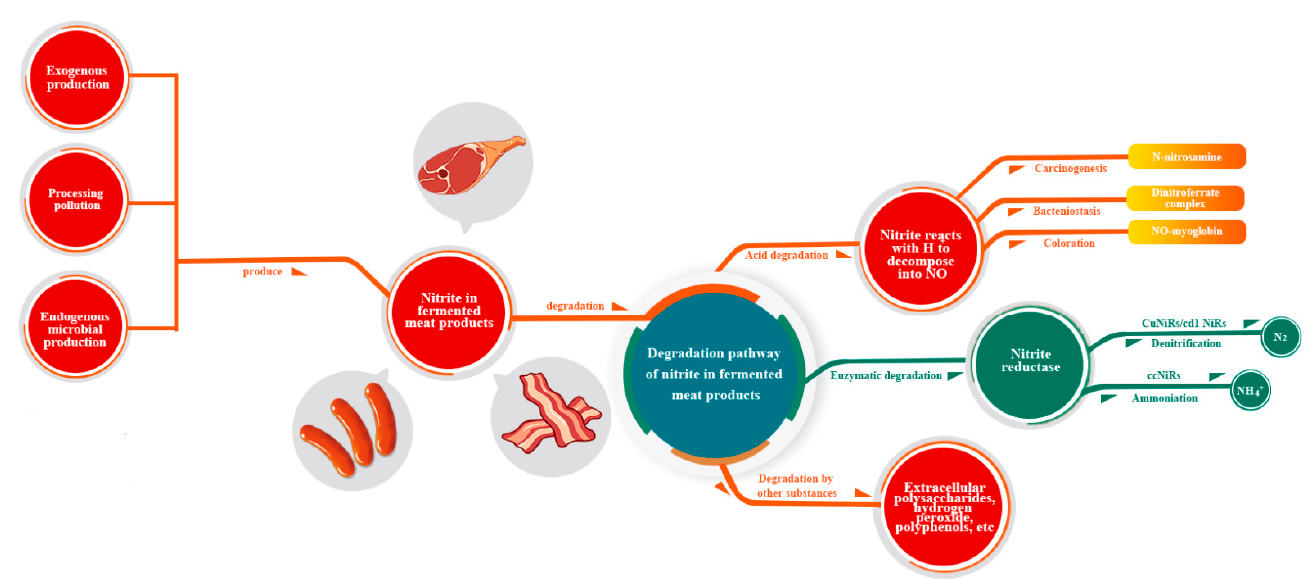
Figure 2. Metabolic pathway of nitrite in fermented meat products.